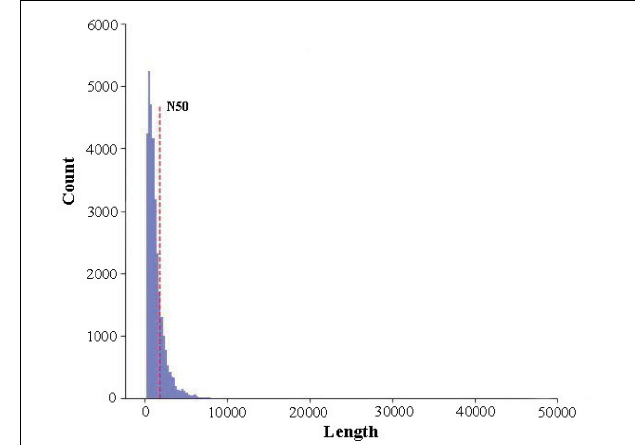
FIGURE 7 | Veen chart showing the predicted LncRNAs shared among the CNCI software, CPC2 software and Pfam database. FIGURE 8 | Histogram showing the length distribution of